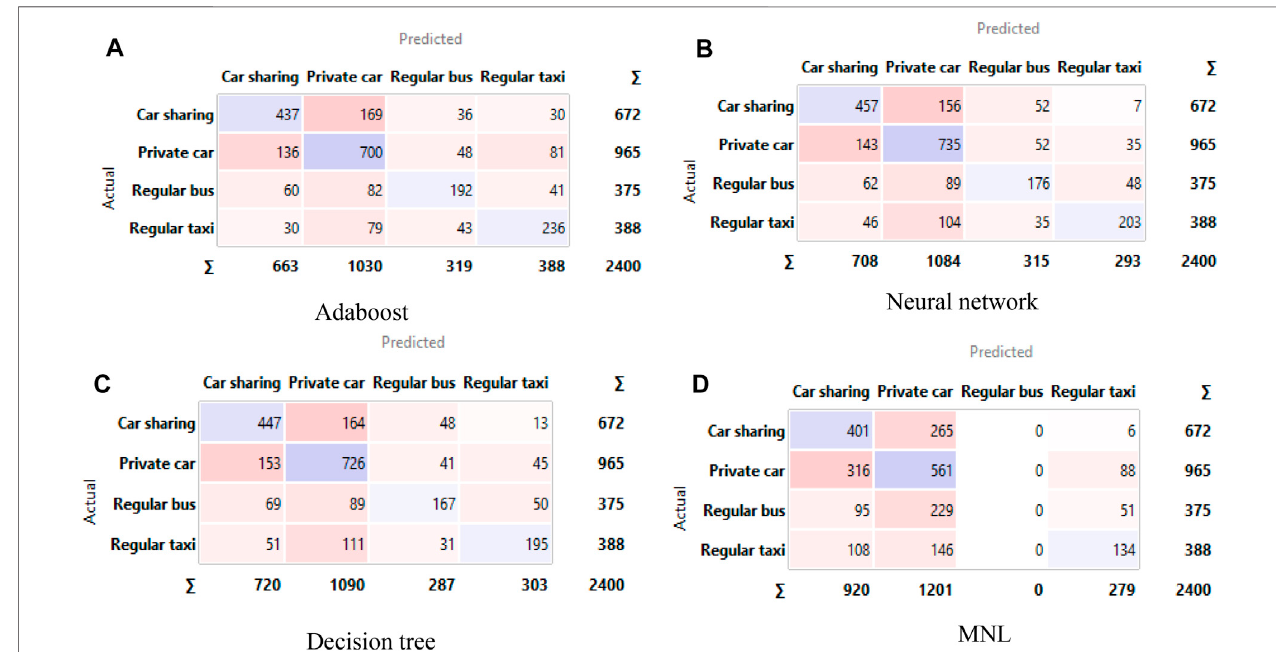
FIGURE 9 | Confusion matrix generated for the different transportation mode. (A) Adaboost (B) Neural network (C) Decision tree (D) MNL.